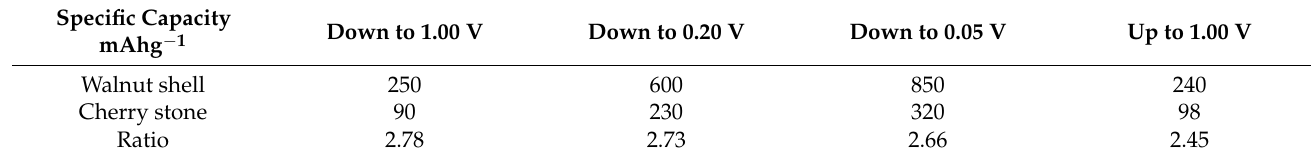
Figure 9. ( a ) Voltage profiles of the walnut shell carbon-based electrodes, during the first 30 cycles conducted at constant current. ( b ) Variation of the specific capacity and charge coefficient as a function of the number of cycles. The electrode load was 7.0 mg. ( c ) Voltage profiles of the cherry stone carbon-based electrodes. ( d ) Variation of the specific capacity and charge coefficient as a function of the number of cycles. Lithium metal was used as counter and reference electrode. Cycling was carried out at constant current between 0.05 and 1.00 V. The electrode load was 7.7 mg. Table 1. First cycle specific capacity in discharge (calculated at different cell voltage values) and in charge. The first two rows report the specific capacity. The last row reports the ratio between the specific capacities.